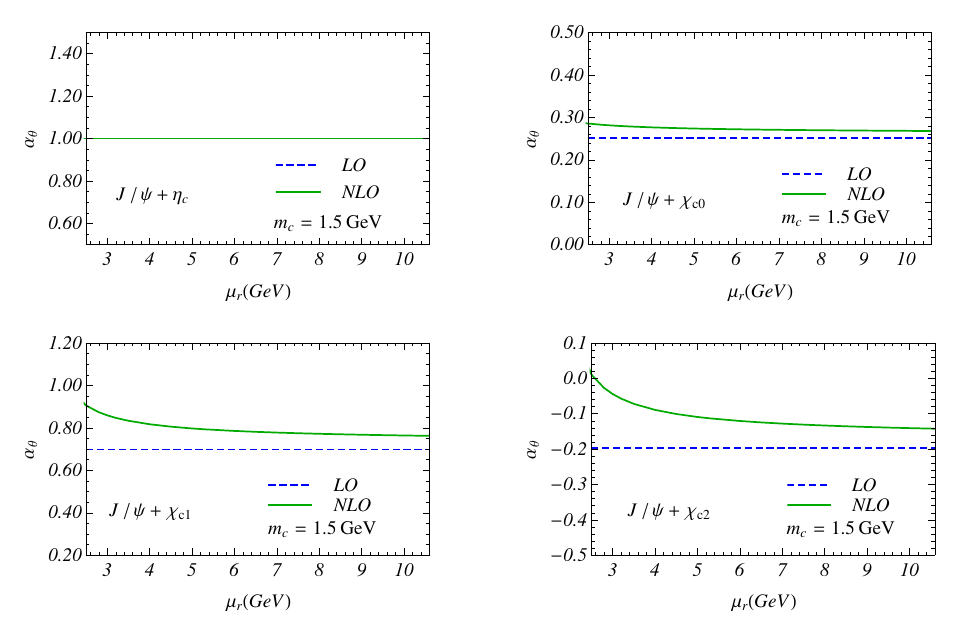
√ s = 10 . 6 GeV and m c = 1 . 5